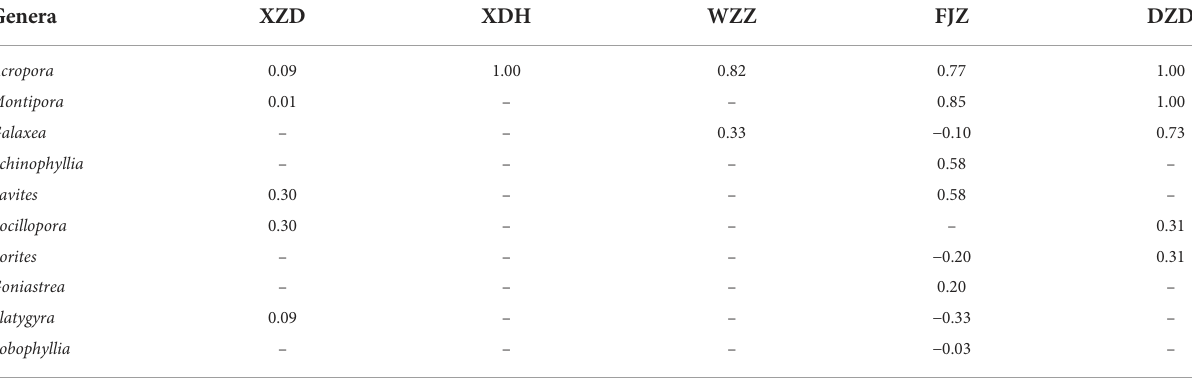
TABLE 2 Feeding preferences of Drupella spp. according to the Ivlev ’ s Electivity Index (E i ) considering the coral genera preyed upon at each station. Genera